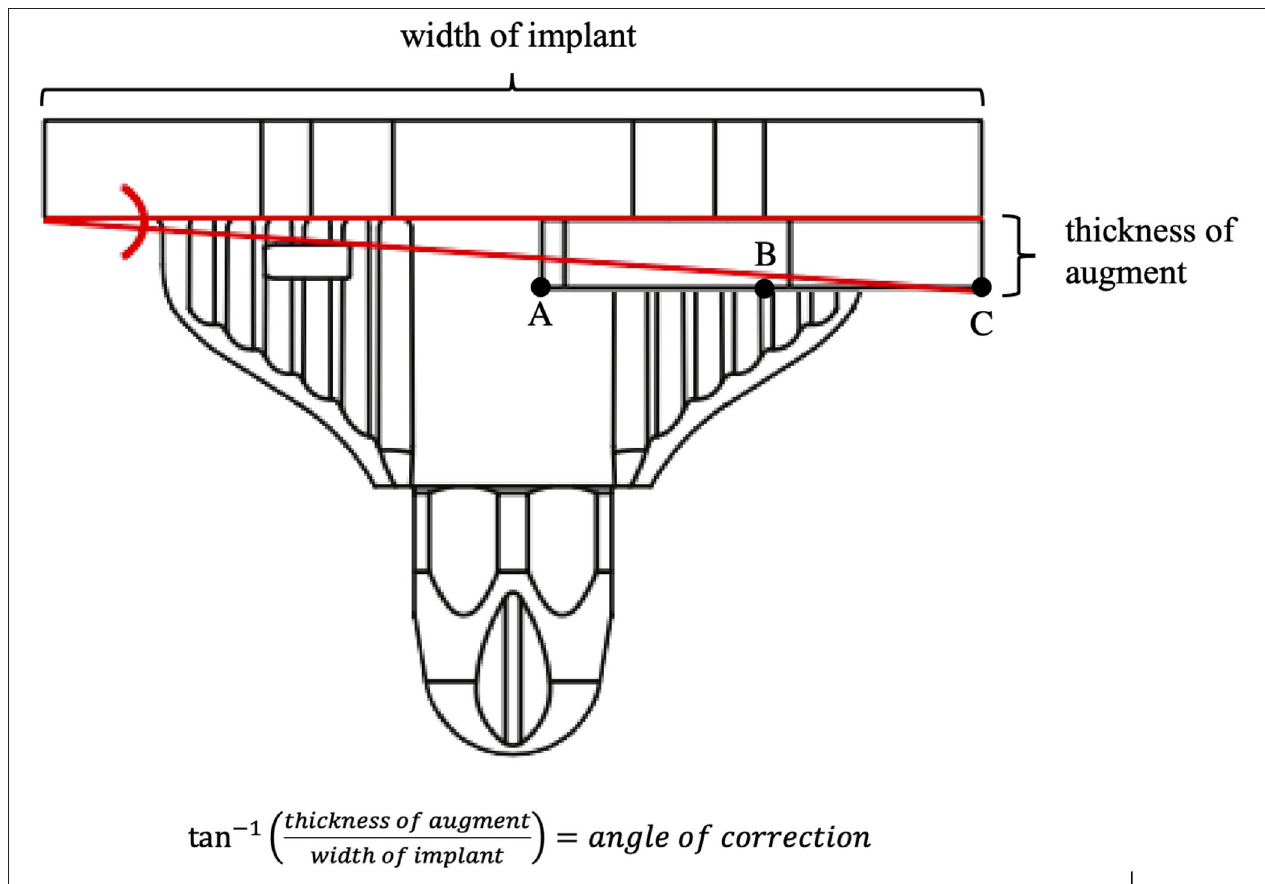
FIGURE 2 | The inverse tangent of the augment’s thickness over the implant’s width can be used to approximate the angular correction given by apposing the component with a unilateral augment to a uniformly flat bone surface. In a purely mathematical sense, the augment would first contact a flat surface at point A. However, from a practical point of view, because of the use of cement and partial impaction in cancellous bone, using point A to calculate the angular correction would overestimate the correction. Thus point B, in the middle of the augment, was assumed to be where a flat plane would intersect the augment. The length of the segment BC was subtracted from the width of the implant in the